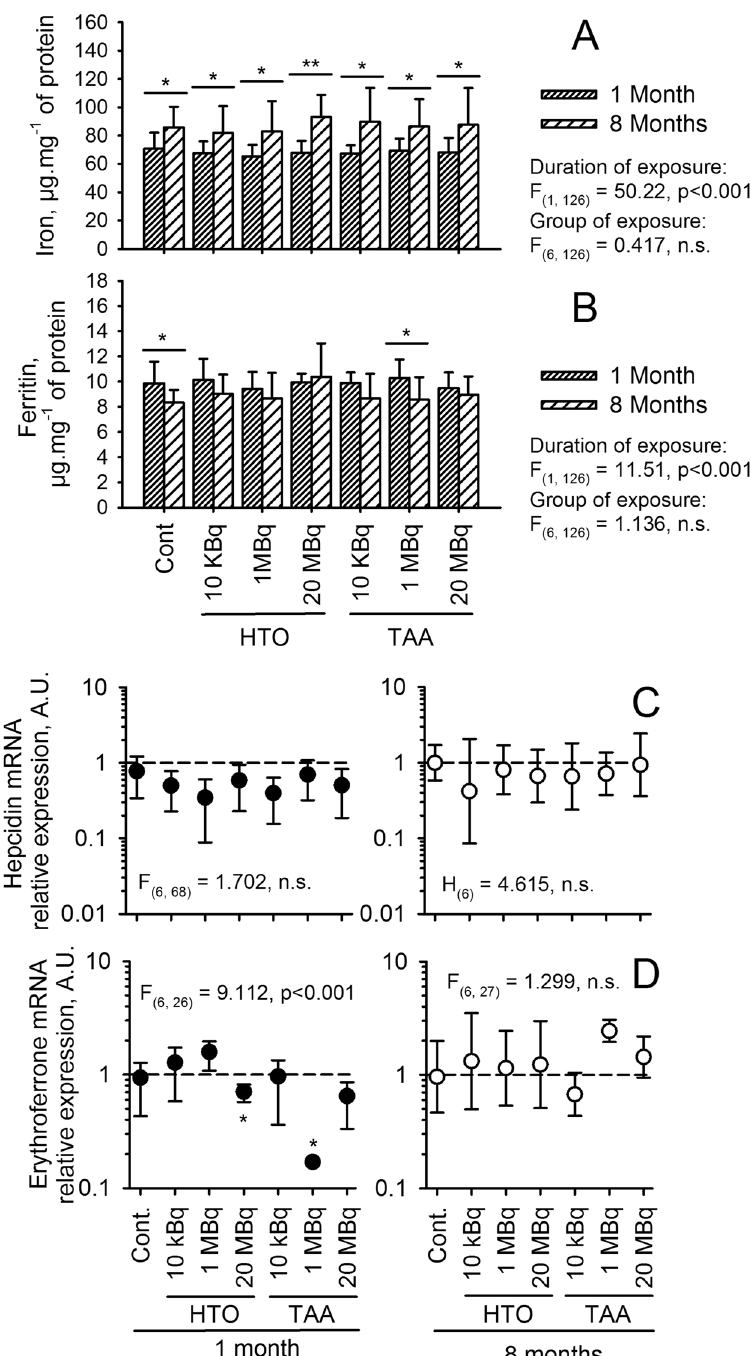
Figure 7. Iron metabolism in the liver. ( A ) Iron concentration and ( B ) ferritin concentration in liver extracts, expressed as mean ± SD of ten animals per group. For iron concentration ( A ), a two-way anova analysis showed a significant difference with duration of exposure (which relates to an age effect) (F (1, 126) = 50.2, p > 0.001) but not with group of exposure (F (6, 126) = 0.42, n.s.). For Ferritin concentration ( B ), difference according to the duration of exposure is significant (age-related effect) (F (1, 126) = 11.5, p > 0.001), but not with the group of exposure (F (6, 126) = 1.14, n.s.). Differences between 1 and 8 months of exposure within the same group of exposure are indicated for * p < 0.05 and ** p < 0.001. ( C , D ) mRNA expression of hepcidin ( C ) and erythroferrone ( D ) after one (left panel) or eight months (right panel) of exposure. Results are presented as a mean ± SD of ten animals and results from the one-way anova or the anova on ranks analysis are indicated for each graph. Significant differences with the control, using a multiple comparison procedure are indicated for * p < 0.05. Since the control group served as the reference for the relative gene expression at each duration of exposure, it was not possible to compare data from the one-month exposure with data from eight-month